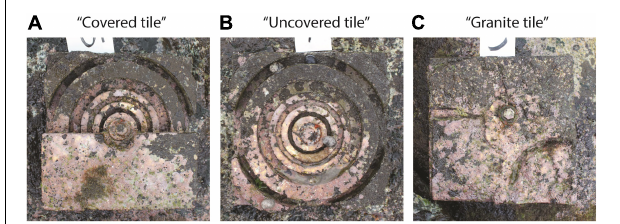
FIGURE 1 | Photographs (taken 6 months after deployment) of the three tile types tested in this study: (A) covered tile, (B) uncovered tile, and (C) granite control tile. Note the underlying tile design and surface area of (A) and (B) are the